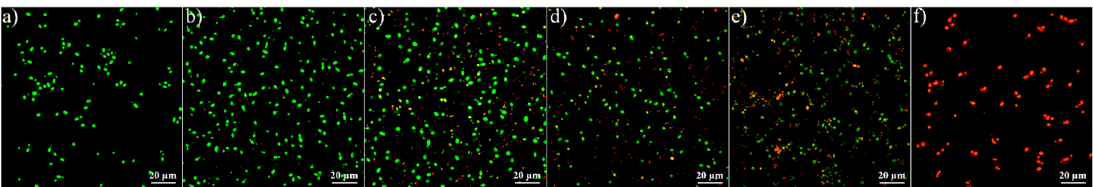
Figure 8. The AO/PI staining shows the live and death cells in all treatments. ( a ) Control treatment with buffer showed a basal growth of R. mucilaginosa . ( b ) Treatment with 0 µg/mg shows an increment of the cell population. ( c ) The maximal increment of viable population of R. mucilaginosa was observed at 16.2 µg/mg of capsaicin. ( d ) Treatment with 32.5 µg/mg causes a decrease in mature viable cells of R. mucilaginosa fluorescent in green channel and an increase in the young death cell in red channel. ( e ) At 48.7 µg/mg, the growth inhibition was observed in the mature cell. ( f ) The mature death cells were observed at 65.0 µg/mg and no young cells were observed.